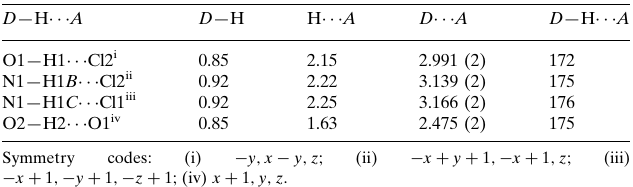
Hydrogen-bond geometry (A˚ , (cid:4)